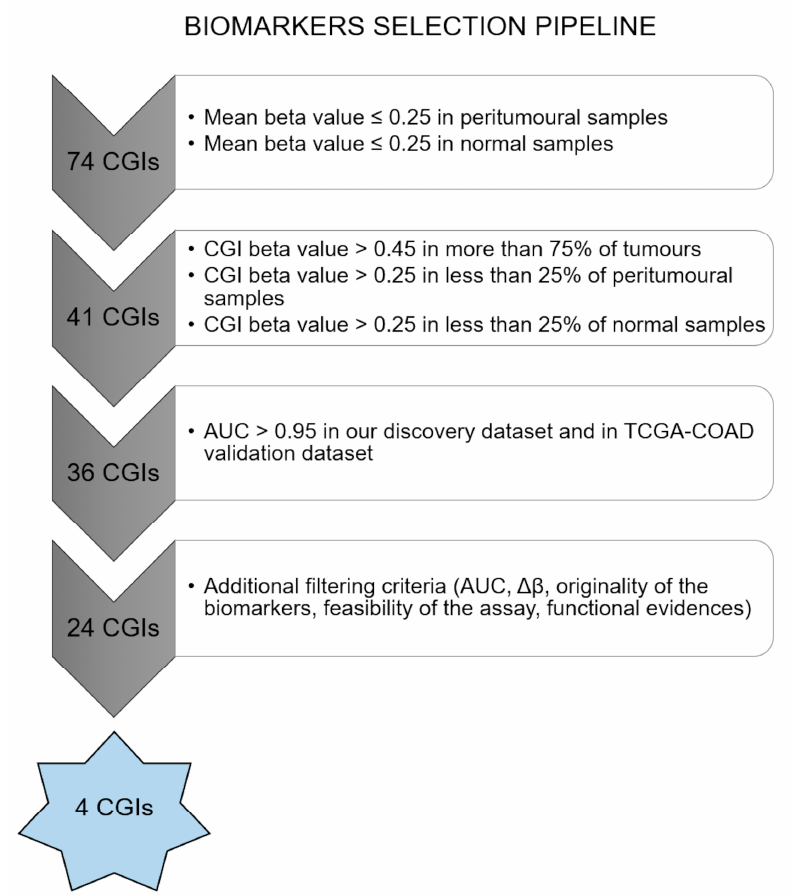
Figure 6. Biomarkers’ selection pipeline. Pipeline for biomarkers selection using methylation data from our previous CRC discovery set and from TCGA-COAD